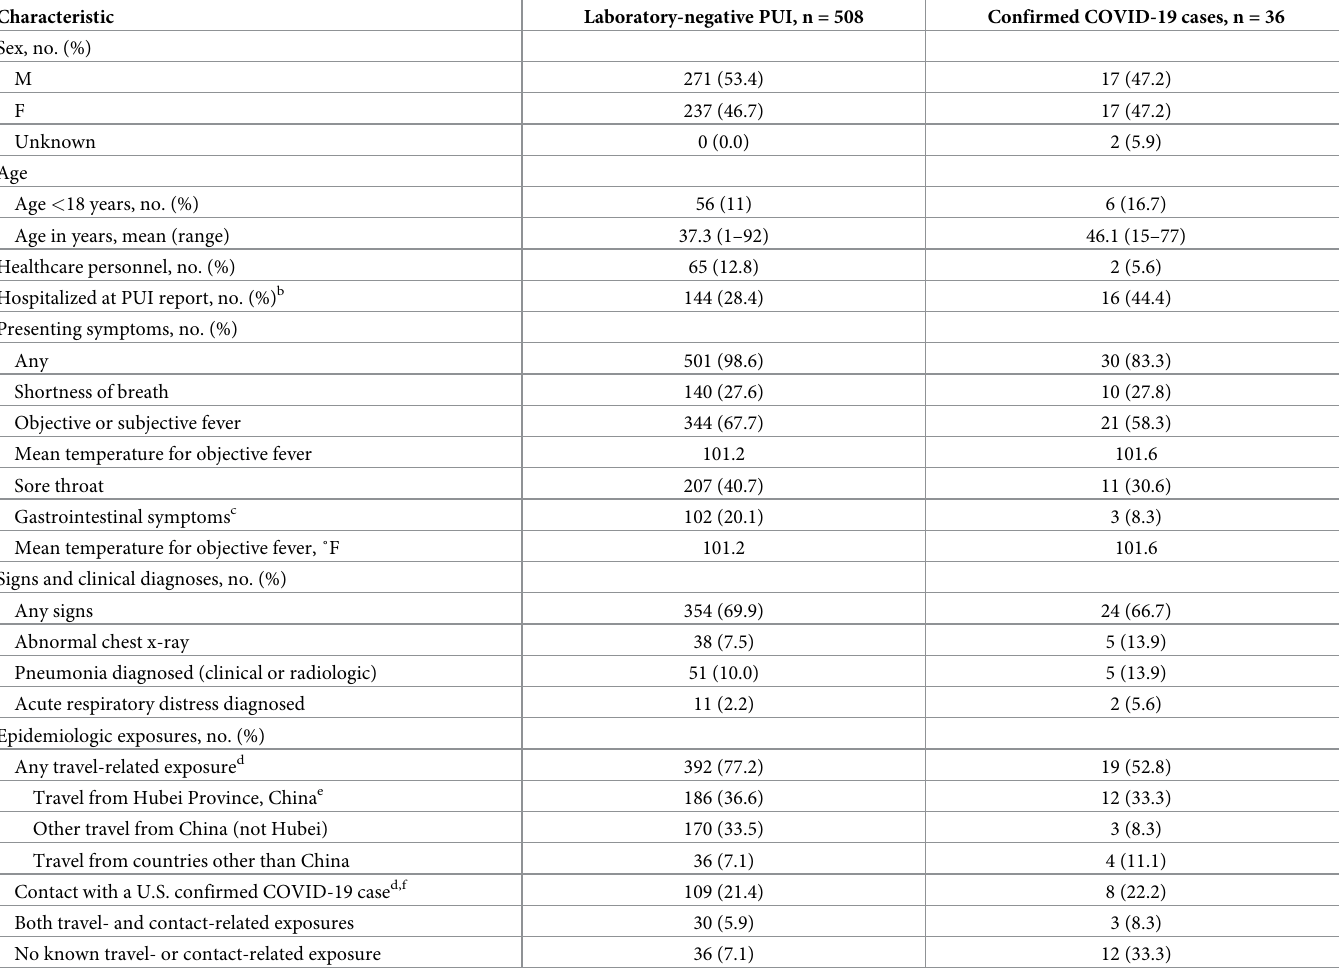
Table 2. Characteristics of U.S. laboratory-negative persons under investigation and confirmed COVID-19 cases, January 17–February 29, 2020 a .